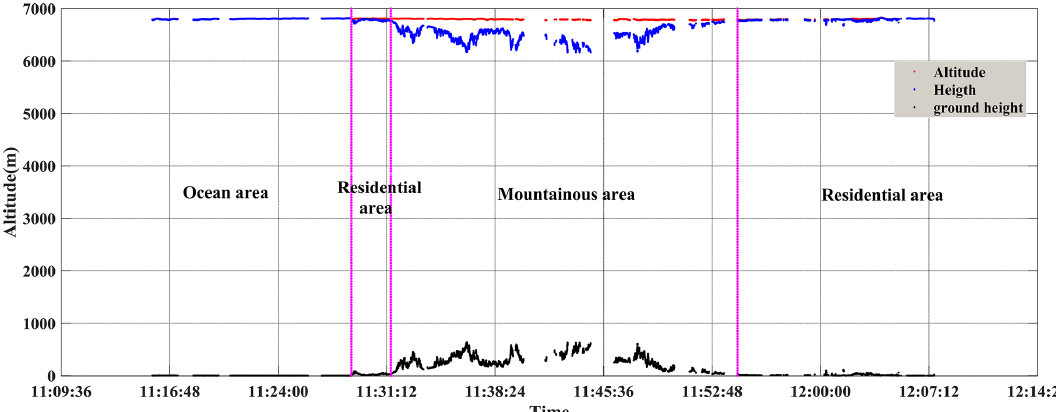
Figure 3. Aircraft flight height and corresponding surface elevation on 14 March 2019. The red dots are the altitude of the aircraft measured by the onboard GPS. The blue scatter points represent the distance between the plane and ground measured by lidar. The black scattered points represent the difference between the altitude measured by the GPS and the distance measured by the lidar, and they also represent the surface elevation. The purplish red vertical line is the dividing line for different surface